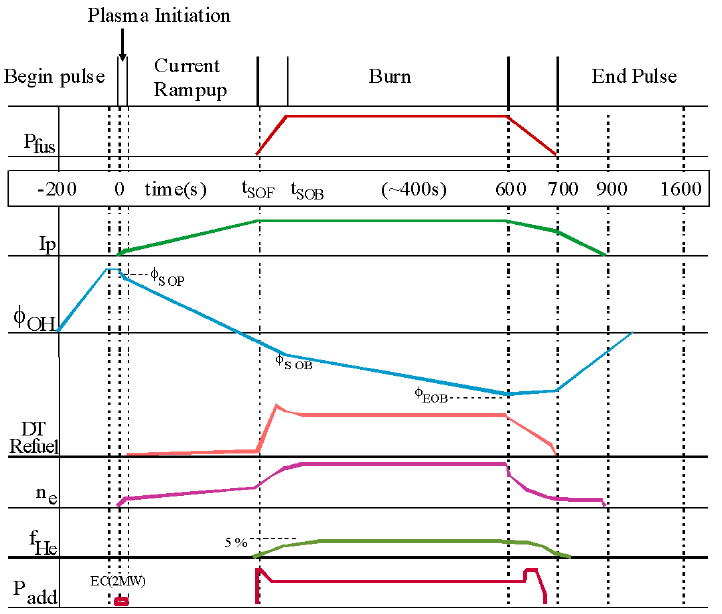
Figure 9. Standard plasma burn operation. P fus = Fusion Power, P add = Added power to initiate fusion, n e = Electron density in the plasma, f He = He density in the plasma, and I p = Plasma current (from ITER Technical Basis [4]). © 2002 IAEA.